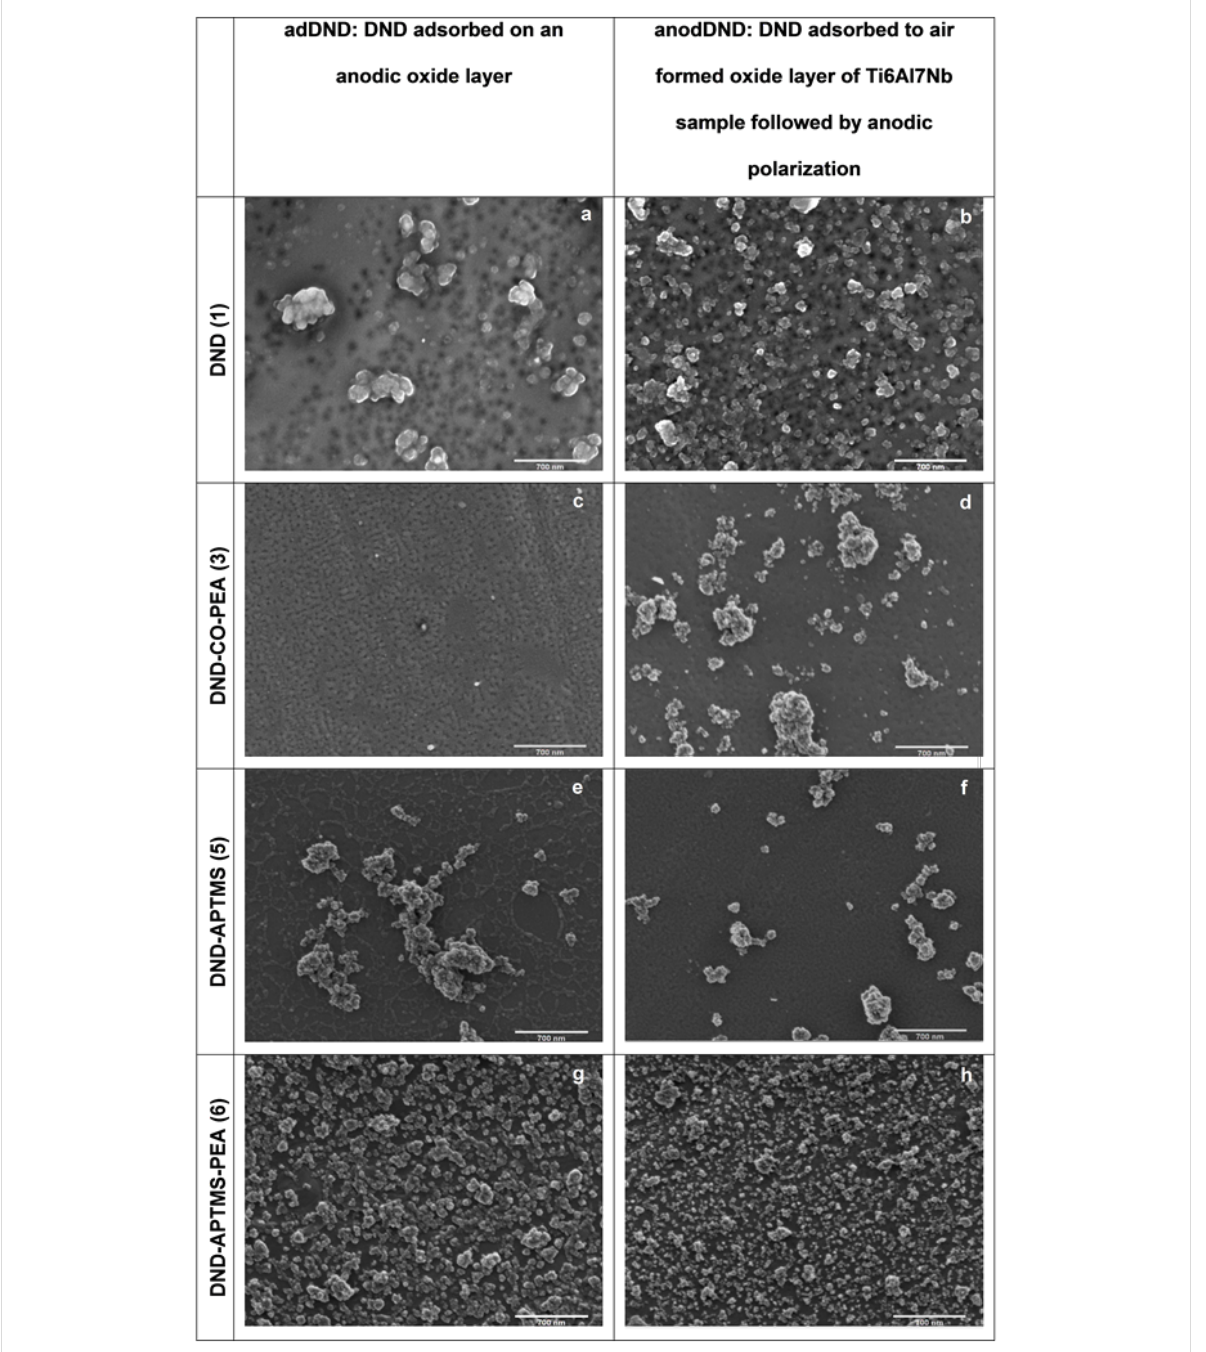
Figure 4: SEM images of titanium anodic oxide surface with: (a,b) unmodified DND; (c,d) DND-COOH functionalized with O -PEA ( 3 ); (e,f) silanized nanodiamonds with APTMS 5 and (g,h) silanized nanodiamonds functionalized with O -PEA 6 . Left column – adDND. DND adsorbed on an anodic oxide layer and right column – anodDND with adsorption of DND on air formed oxide layer of Ti sample followed by anodic polarization. Anodic polarization was consistently carried out at 60 V and 50 mA/cm 2 .